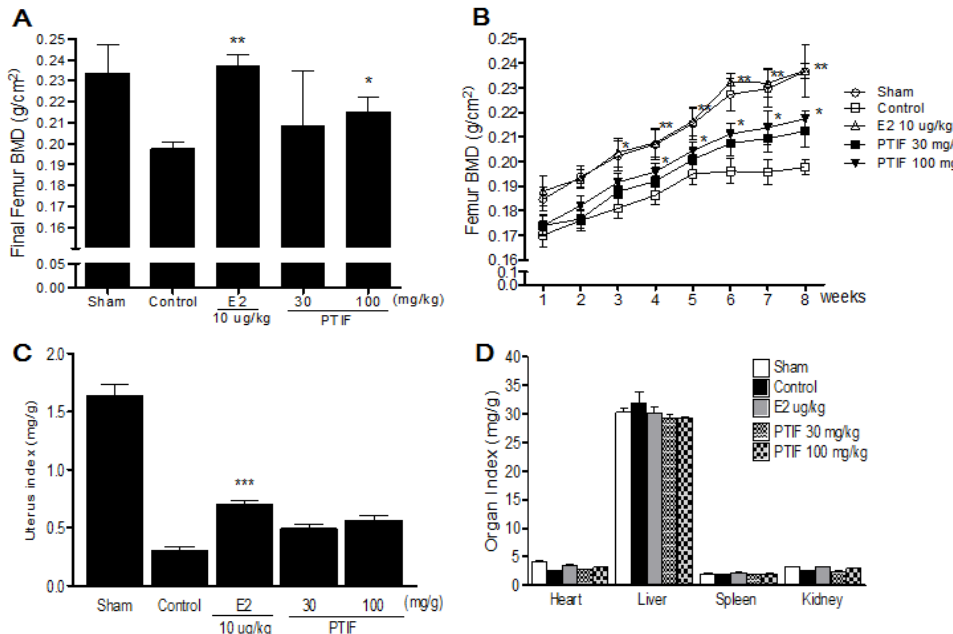
Figure 4. Effects of PTIF on final femur one mineral density (BMD) ( A ), femur BMD changes ( B ), uterus index ( C ) and organ index ( D ). Data are the mean ± SEM values ( n = 12 per group). Femur BMD changes were statically significant vs . control by repeated-measure ANOVA. Final femur BMD and organs weights were compared with control (one-way ANOVA). * p < 0.05, ** p < 0.01 and *** p < 0.001, significantly different from the OVX-control group.